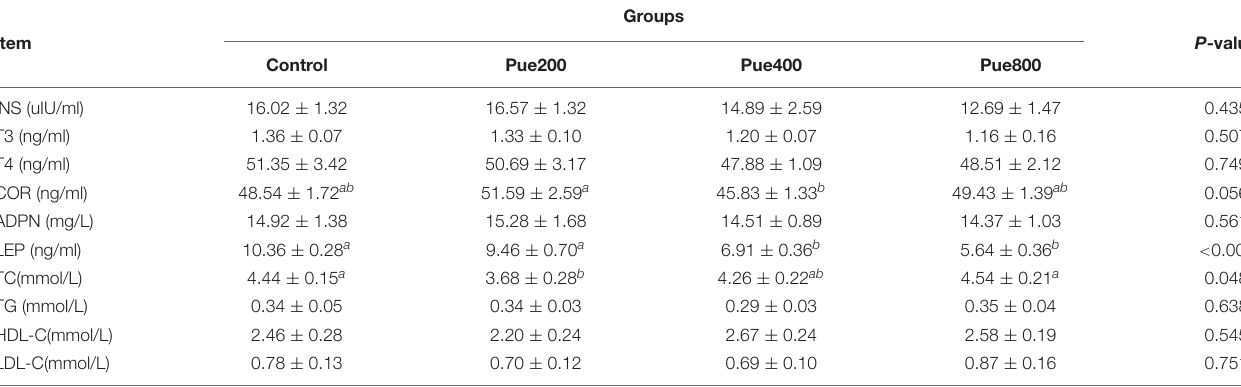
TABLE 3 | Effects of puerarin on the blood biochemical characteristics in beef cattle under hot environment.